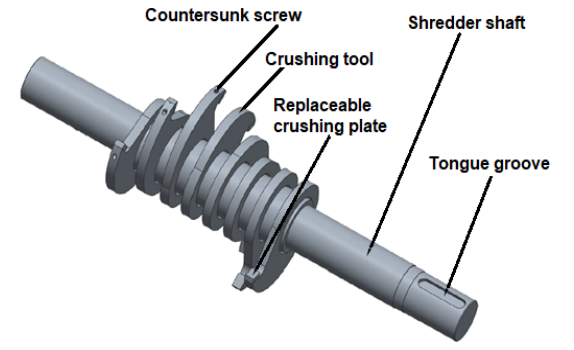
Figure 3 Crusher rotor with replaceable crushing plates